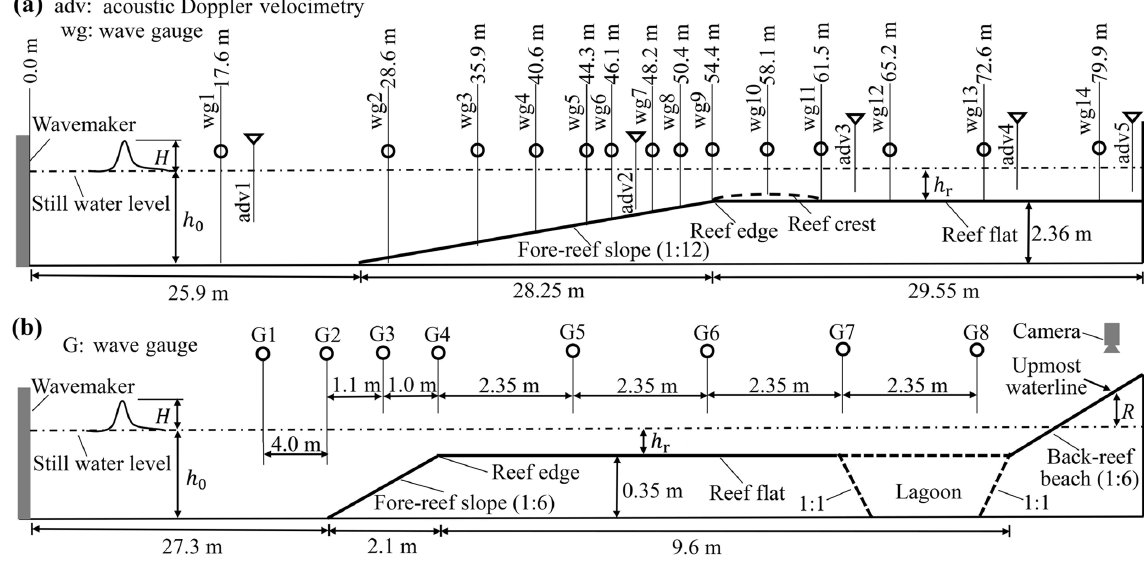
Figure 1. Experiment settings for (a) Roeber (2010) and (b) Yao et al. (2018). Table 1. Reef configuration and wave condition for the tested scenarios. Scenario Offshore Offshore Reef- Fore- Reef- Reynolds Remarks Source ID wave water flat